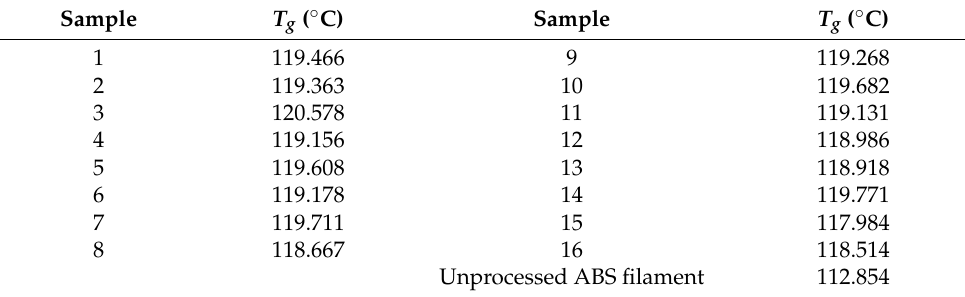
Table 4. Values of glass transition temperature measured by DMA.